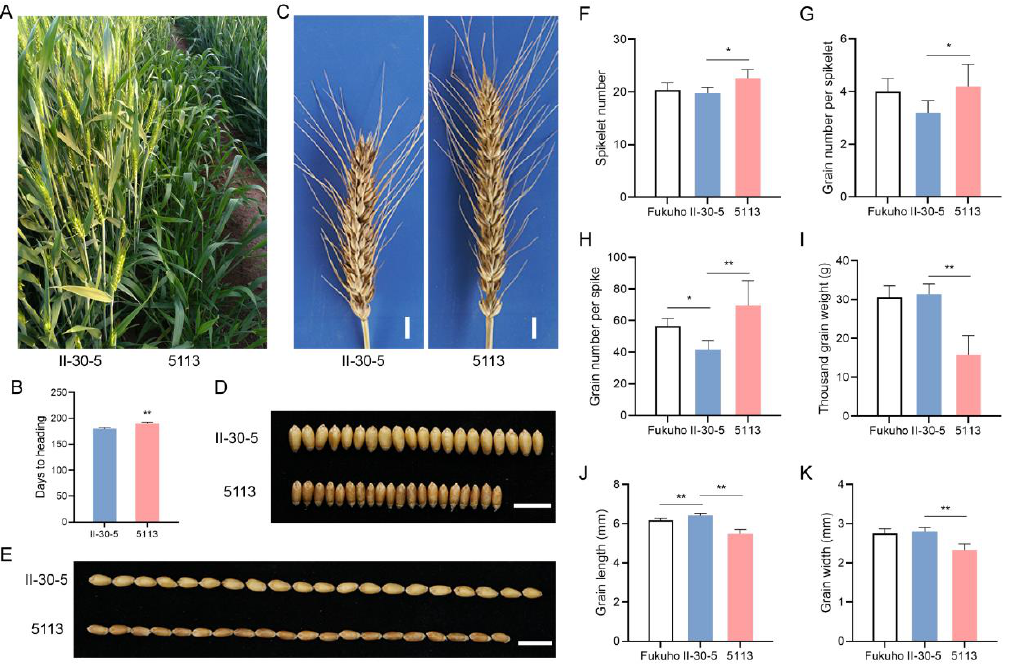
Figure 2. The differences between 5113 and II-30-5 in heading date, GNS, and thousand-grain weight in the field. ( A ) II-30-5 headed significantly earlier than 5113. ( B ) Days to heading of 5113 and II-30-5. ( C ) Comparison of the spikes of 5113 and II-30-5 at maturity. Bar = 1 cm. ( D ) Comparison of the grain widths of 5113 and II-30-5. Bar = 1 cm. ( E ) Comparison of the grain length of 5113 and II-30-5. Bar = 1 cm. ( F ) Spike number of 5113 and II-30-5. ( G ) Grain number per spikelet of 5113 and II-30-5. ( H ) Grain number per spike of 5113 and II-30-5. ( I ) Thousand-grain weight of 5113 and II-30-5. ( J ) Grain width of 5113 and II-30-5. ( K ) Grain length of 5113 and II-30-5. Error bars represent the SD of three biological replicates. Asterisks indicate statistically significant differences between addition lines and controls: *, p < 0.05; **, p < 0.01.